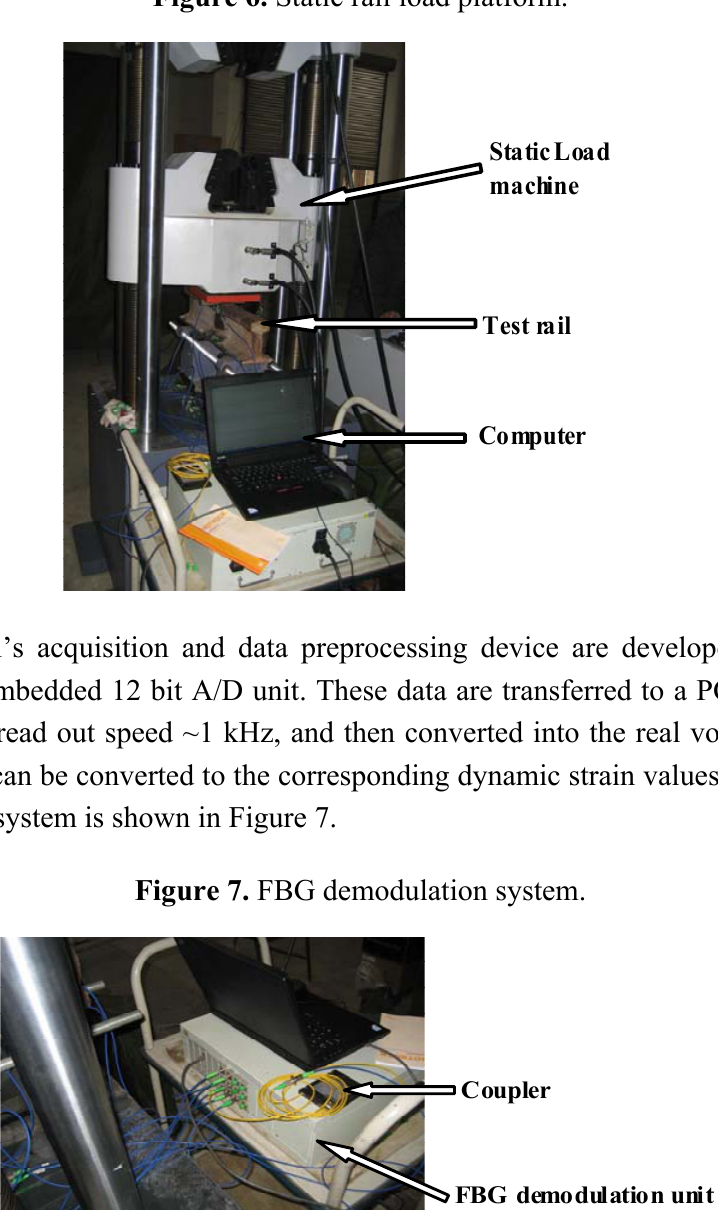
Figure 6. Static rail load platform.